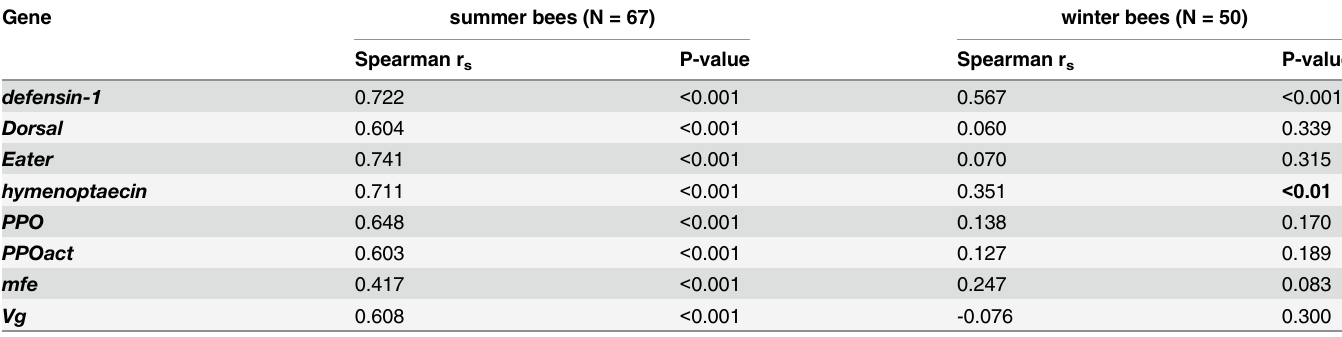
Table 3. Spearmans r s correlation of genes expressions with DWV load on summer and winter bees.